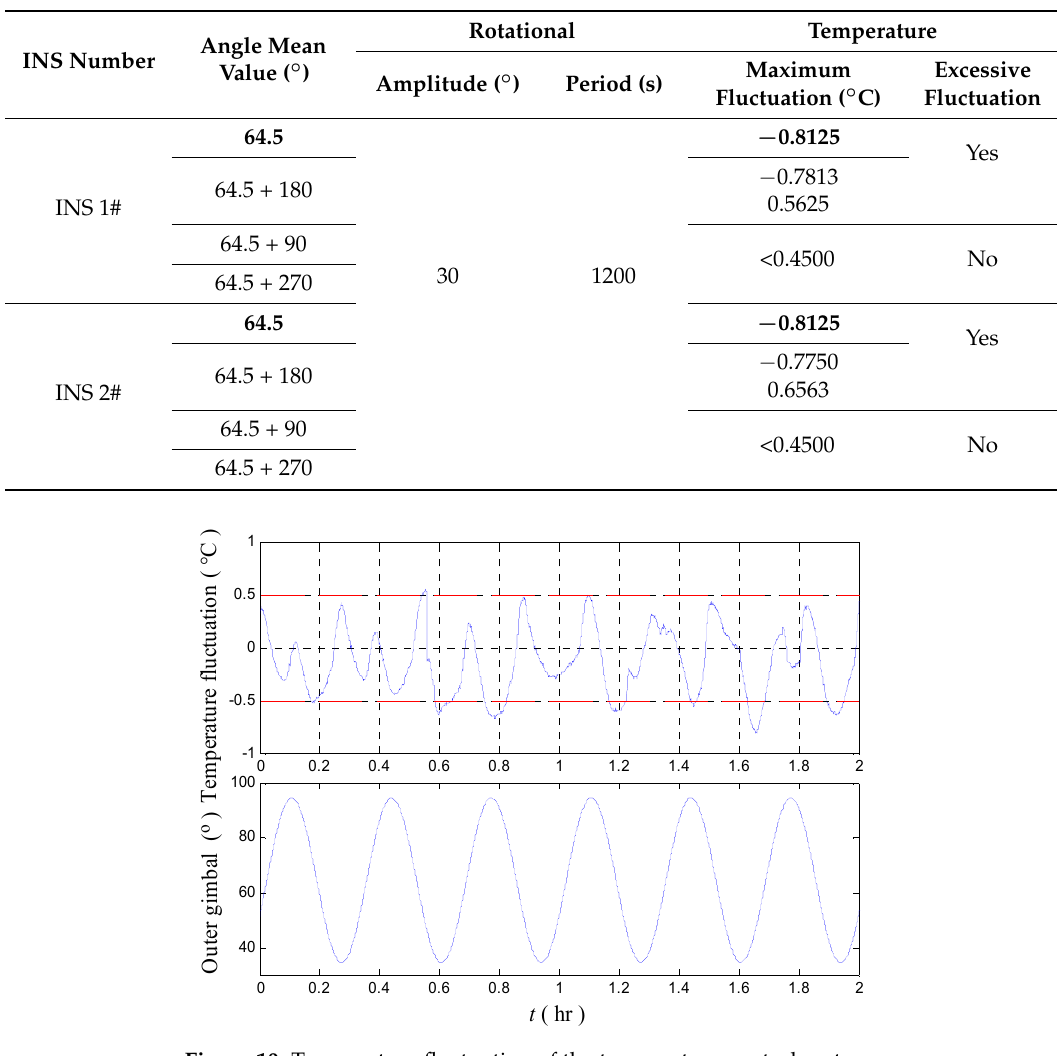
Figure 10. Temperature fluctuation of the temperature control system.